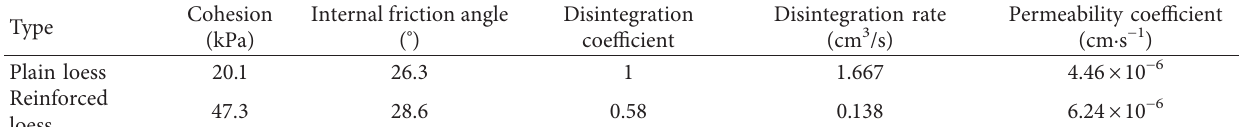
Table 2: Antierosion ability parameters of the control loess and the reinforced loess.